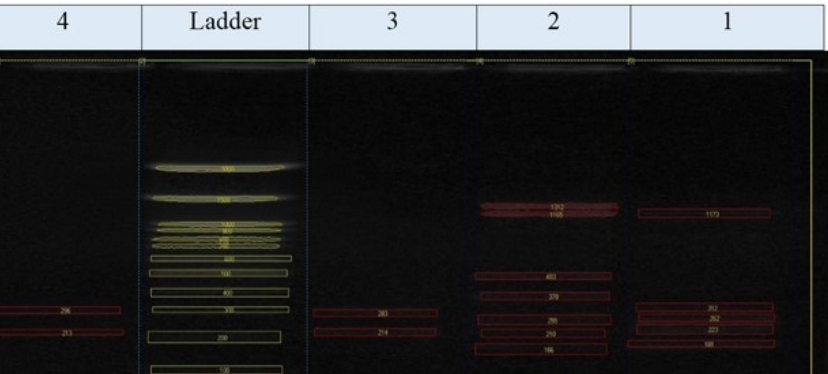
Figure 5. ERIC bands (measured by BioDocAnalyze software for installation and image acquisition on the computer).